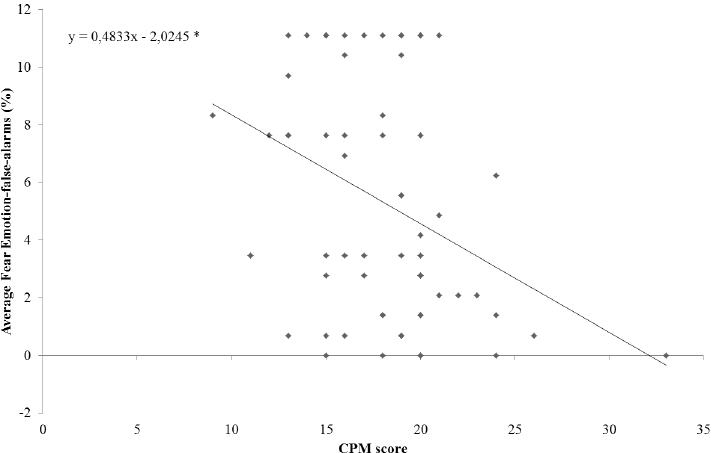
Fig 5. CPM-score predicts average Fear Emotion-false-alarms. Plot of participants ’ CPM-score versus average Fear Emotion-false-alarms. * = p < 0.05.